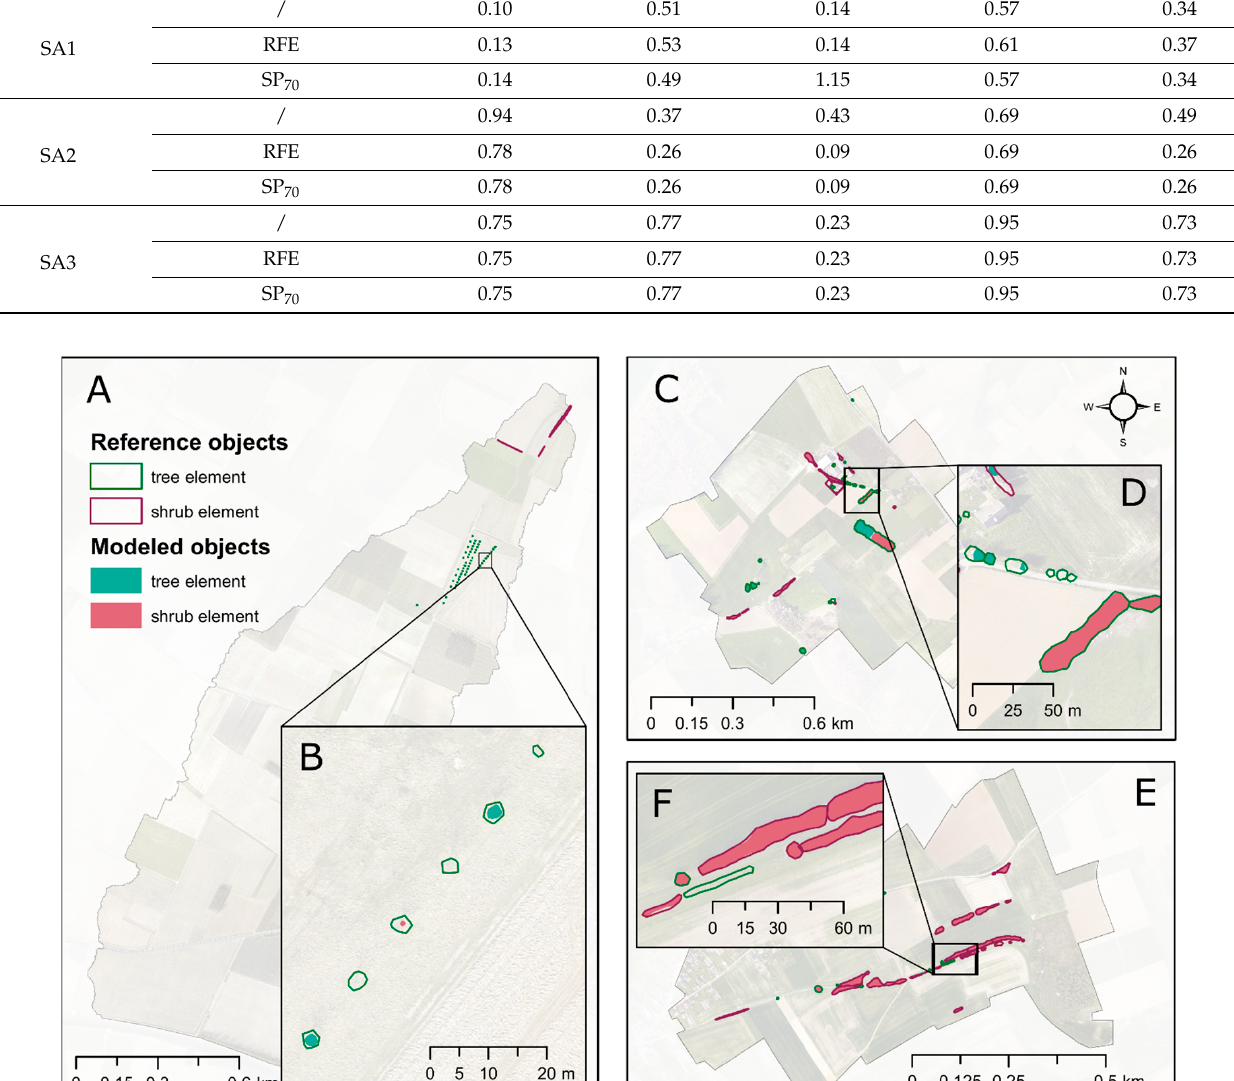
Figure 5. Reference 2D objects and modelled 2D objects in SA1 ( A , B ), SA2 ( C , D ), and SA3 ( E , F ).